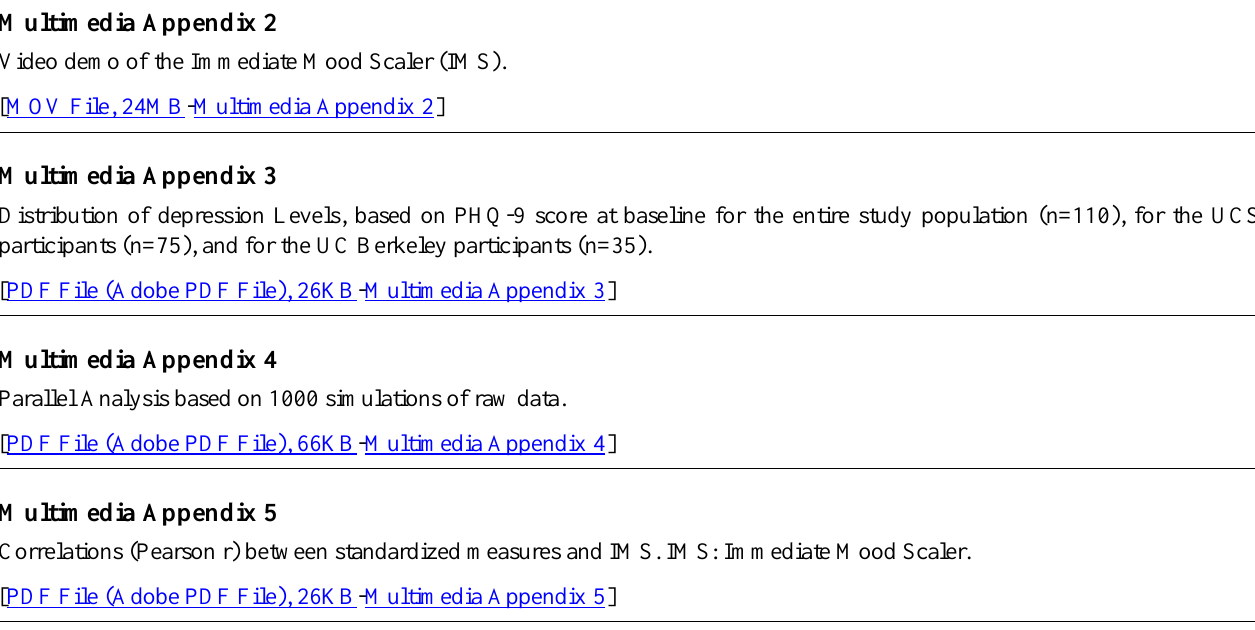
table). IMS: Immediate Mood Scaler. PHQ-9: Patient Health Questionnaire,